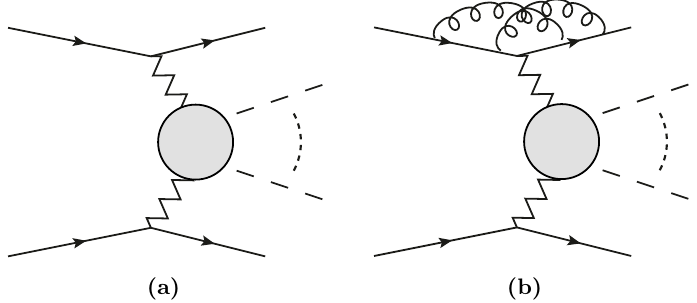
Figure 3. Born diagram for the production of n Higgs bosons in VBF (a) and representative 2-loop factorisable corrections